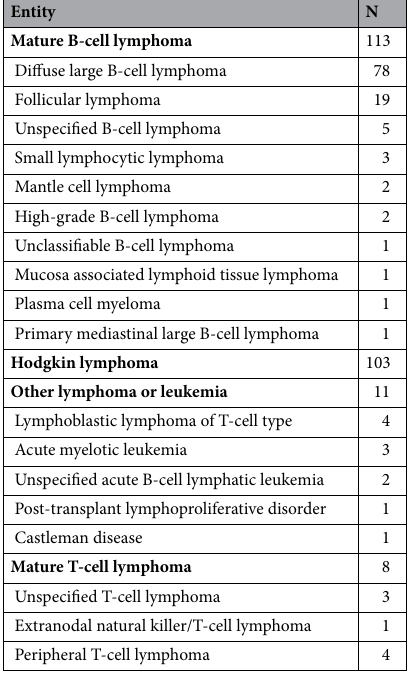
Table 1. Distribution of lymphoma entities in the disease